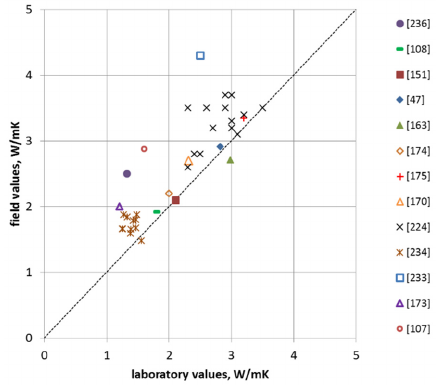
Figure 19. Comparison of laboratory and field-derived thermal conductivity values based on data in